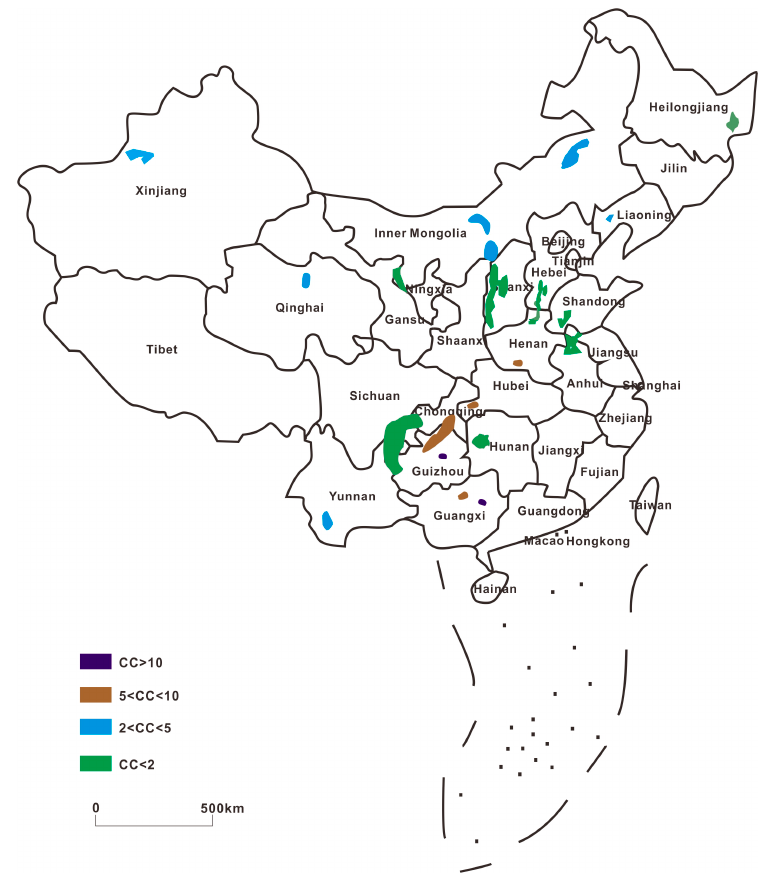
Figure 2. The fluorine enrichment distribution of Chinese coal (based on reported data